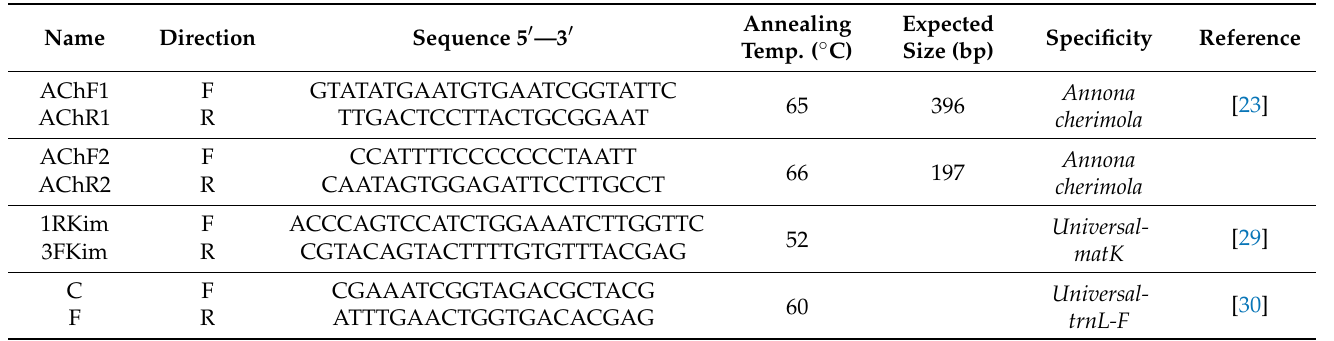
Table 2. Details of the primers used and designed including sequence, PCR annealing temperatures, expected PCR product sizes, target species, and